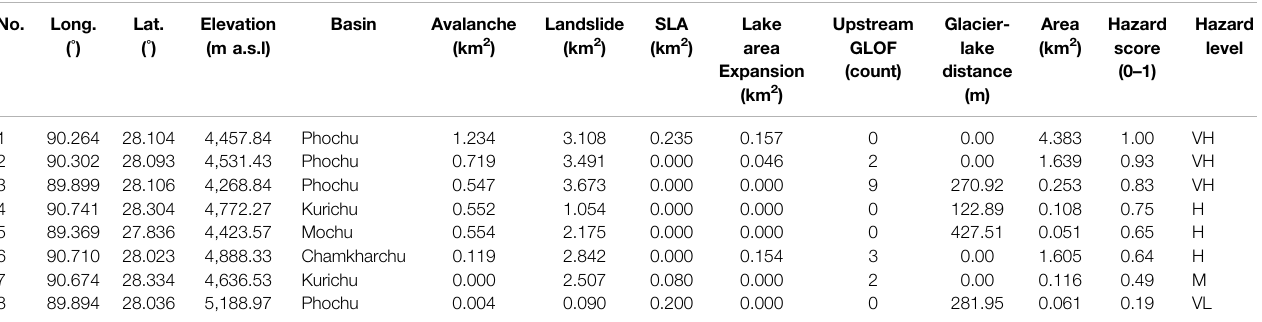
TABLE 4 | Details of the lakes used to validate the hazard assessment